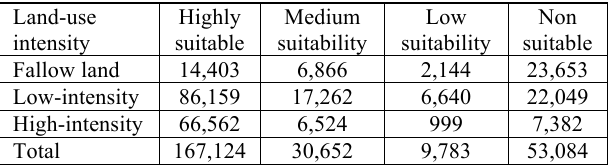
Table 3: Current land-use intensity of cropland and its suitability for surface water irrigation in the delta region of Bangladesh. Suitability classes are the result of an intersection of soil and water salinity levels as defined in Table 1. Numbers indicate the area in ha of land that are within a 385 m buffer adjacent to water bodies on which water was detectable in late March of 2014. Land in the Lowland and Very Lowland classes were excluded from these